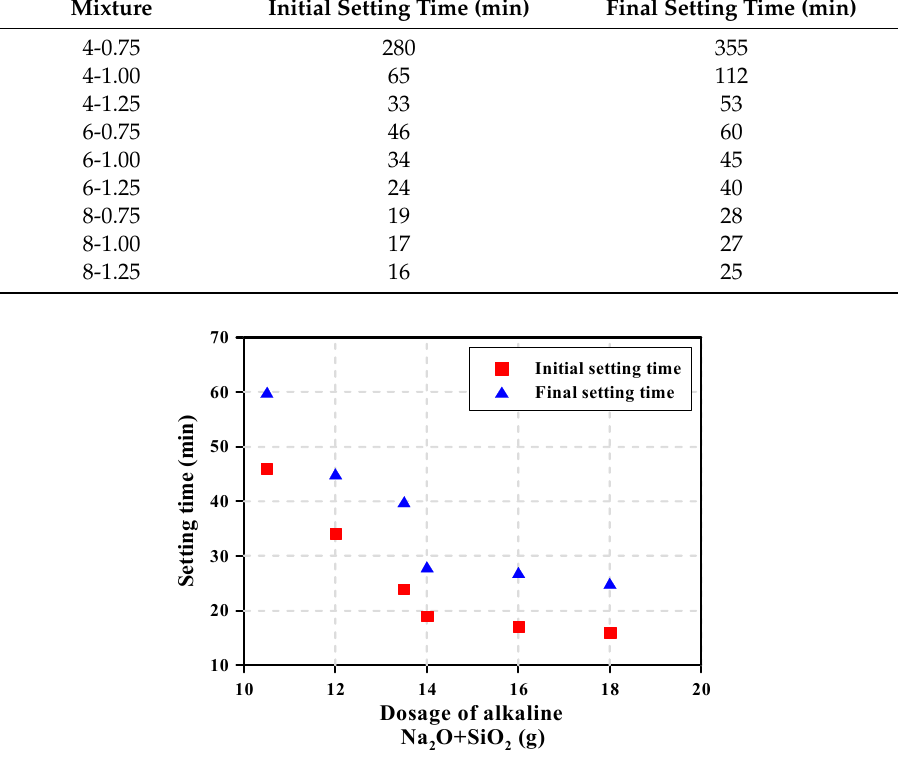
Figure 7. Setting time of AAS paste by the dosage of alkaline.